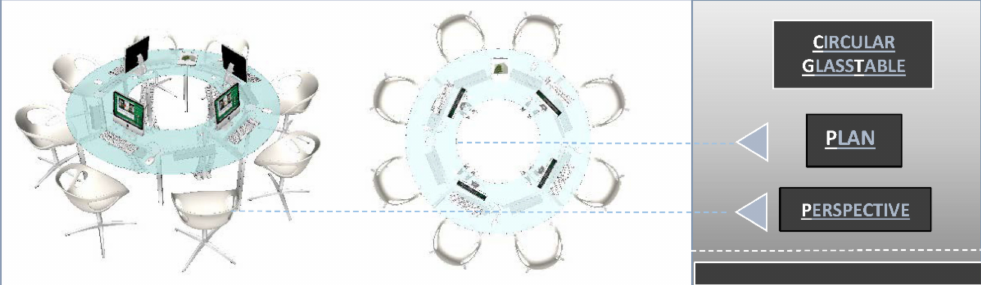
Figure 22. The library contains 6 modern glass circular tables, each table accommodates 8 people, and the total number of round tables accommodates 48 people.